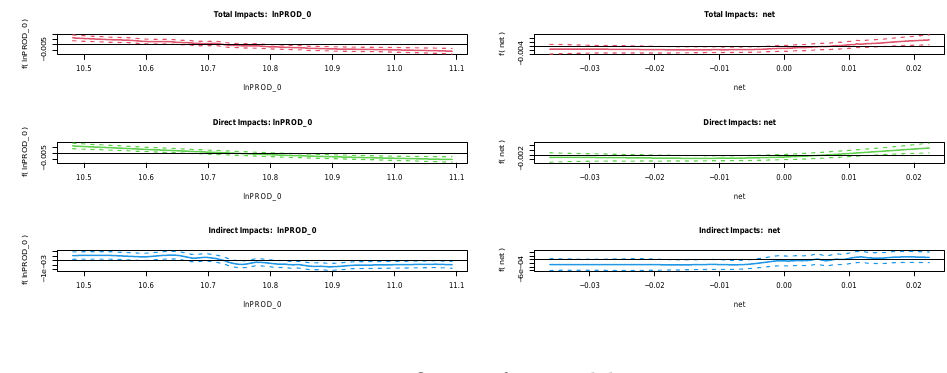
Figure 4: Output from codebox